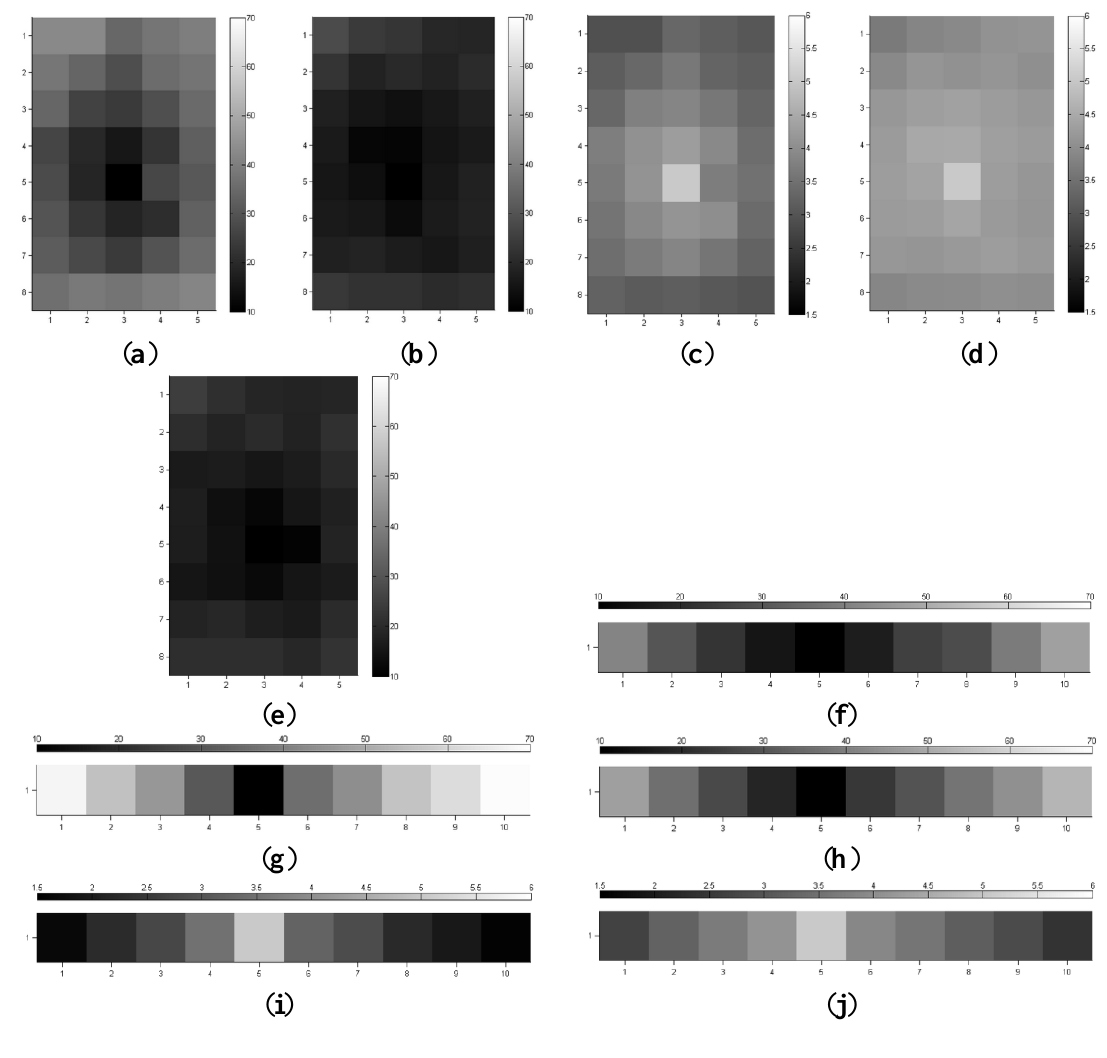
Figure 6. The homing error and distribution quality. The axes denote the positions where the homing errors are computed. ( a , b ) show the homing error in the room using features extracted by the standard SURF and the proposed approach, respectively; ( c , d ) show the distribution quality corresponding to the results in ( a , b ); ( e , f ) show the homing error in the room and the corridor, respectively using the method in [4]; ( g , h ) show the homing error in the corridor using features extracted by the standard SURF and the proposed approach, respectively; ( i , j ) show the distribution quality corresponding to ( g , h